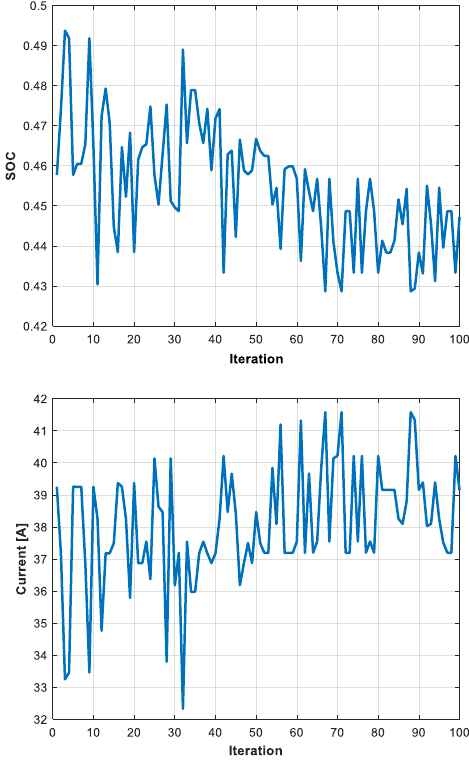
Figure 10. Variation of solutions for the fuel mass and cruise range in optimization Problem 2.